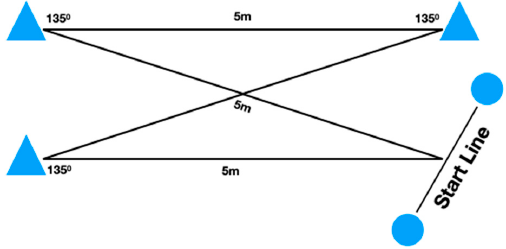
Figure 2. Schematic presentation of the 135 ◦ change of direction test. Circles represent the positions of the photocells.